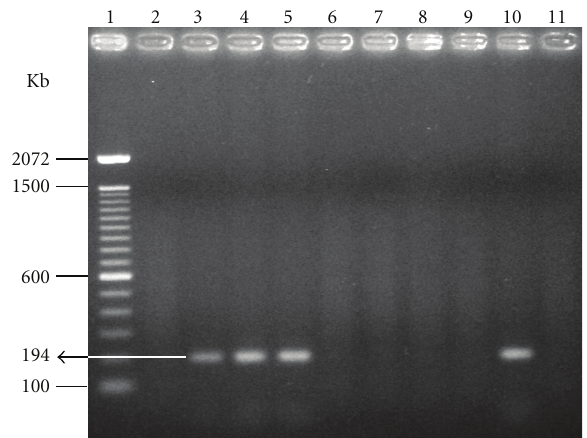
Figure 1: Electrophoresis in 2% agarose gel of PCR product extract from seminal samples of rams experimentally infected with T. Figure 2: Electrophoresis in 2% agarose gel of PCR product extract